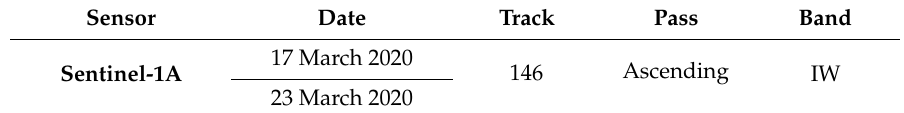
Table 1. Overview of used satellite scenes.